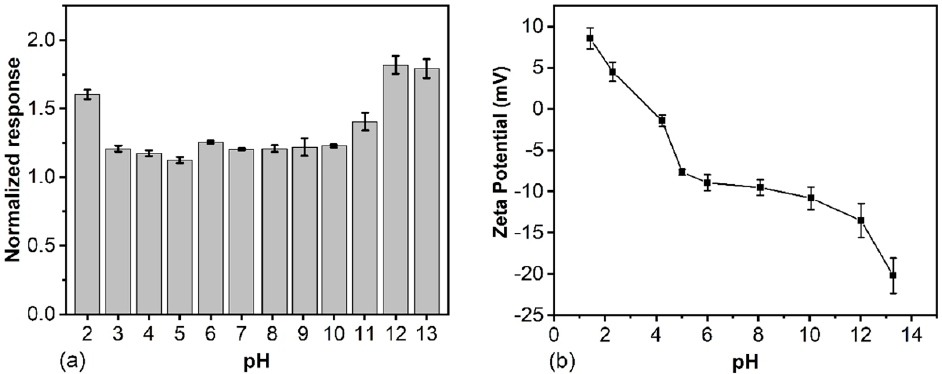
Figure 5. ( a ) The effect of varying pH on the fluorescent intensity and ( b ) the zeta potential with varying pH of the nanomaterial in a suspension of DI water.